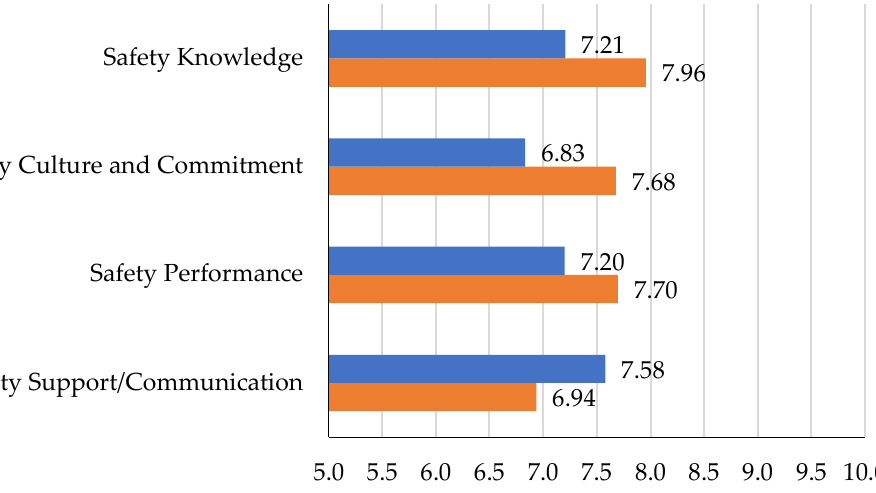
Figure 4. Comparing the opposite groups’ evaluations in four categories of safety perception.